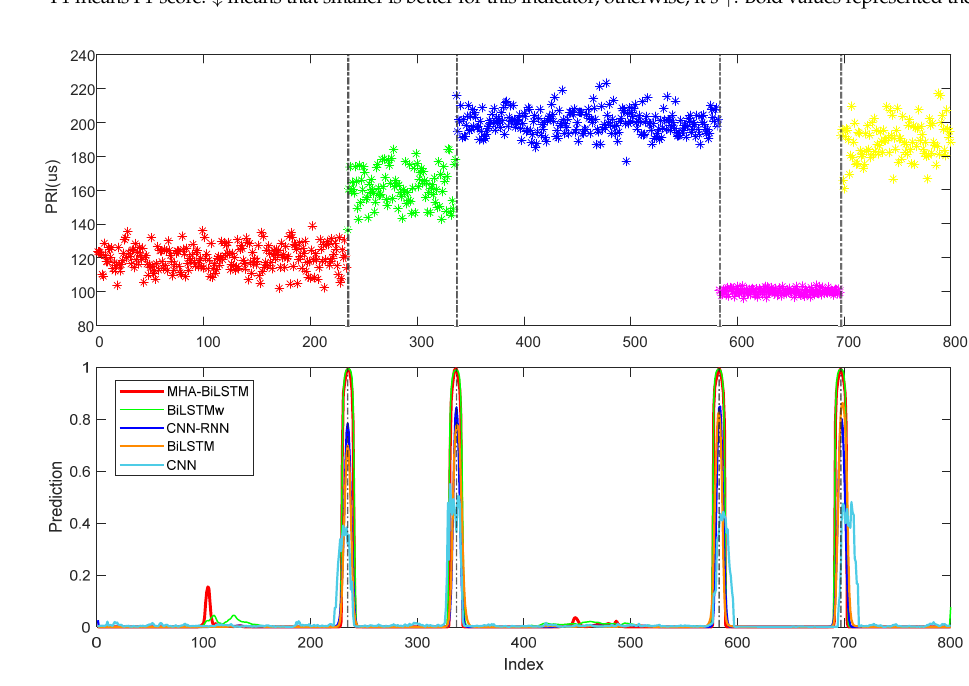
Figure 7. Example of predicted label sequences on jittered PRI, including 4 change points (gray dashed). The horizontal axis is the PRI index, and the vertical is the probability that the point is a change